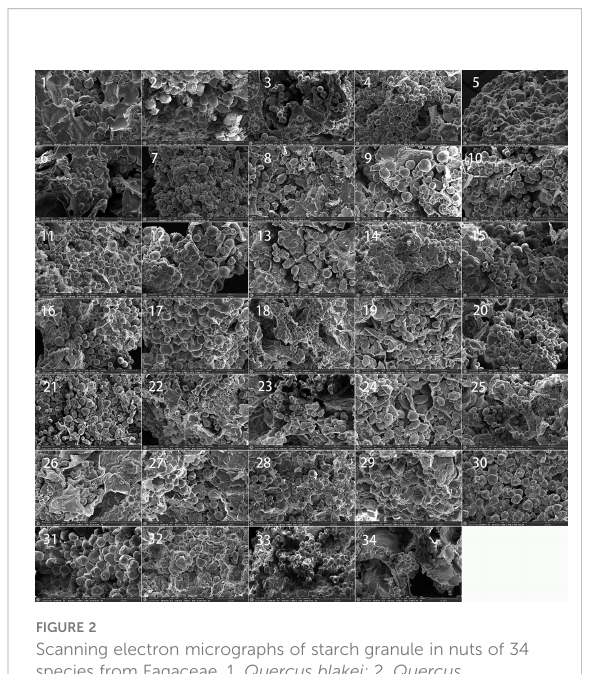
FIGURE 2 Scanning electron micrographs of starch granule in nuts of 34 species from Fagaceae. 1, Quercus blakei; 2, Quercus argyrotricha ; 3, Quercus augustinii ; 4, Quercus litseoides ; 5, Quercus kouangsiensis ; 6, Quercus fl euryi ; 7, Quercus lamellosa ; 8, Quercus serrata ; 9, Quercus sessilifolia ; 10, Quercus gilva ; 11, Lithocarpus elizabethiae ; 12, Quercus kiukiangensis ; 13, Quercus schottkyana ; 14, Lithocarpus pachylepis ; 15, Lithocarpus longipedicellatus ; 16, Lithocarpus sp.; 17, Lithocarpus xylocarpus ; 18, Lithocarpus fenzelianus ; 19, Quercus longispica ; 20, Quercus marlipoensis ; 21, Castanea seguinii ; 22, Quercus cocciferoides ; 23, Quercus franchetii ; 24, Quercus phanera ; 25, Quercus aliena ; 26, Quercus variabilis ; 27, Lithocarpus craibianus ; 28, Lithocarpus longanoides ; 29, Lithocarpus mairei ; 30, Lithocarpus balansae ; 31, Castanopsis orthacantha ; 32, Lithocarpus skanianus ; 33, Lithocarpus dealbatus ; 34, Lithocarpus longinux